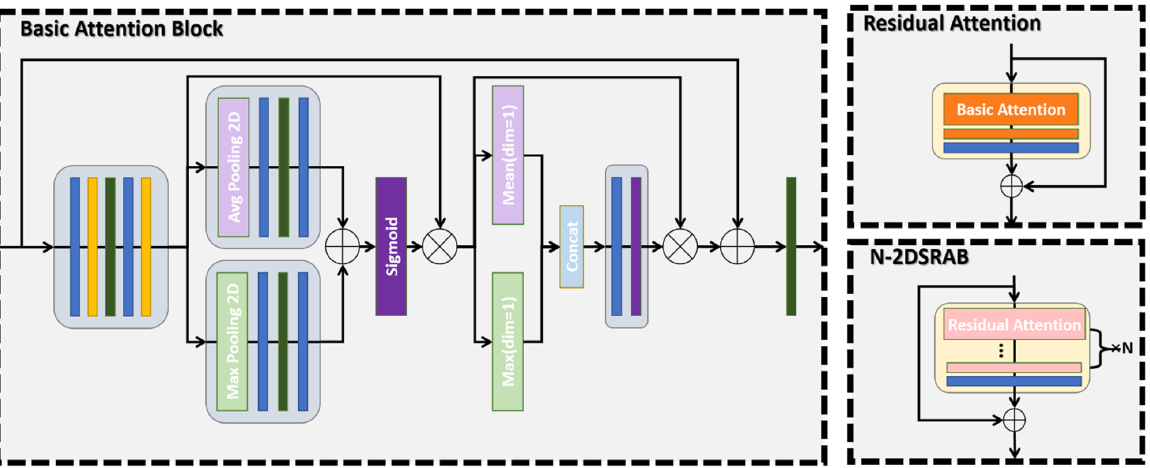
Figure 5. The structure of the proposed attention module 2DSRAB and the structure of its main components. On the left is the basic attention block, and on the upper right is the residual attention block. On the lower right is the 2DSRAB block consisting of N residual attention blocks.